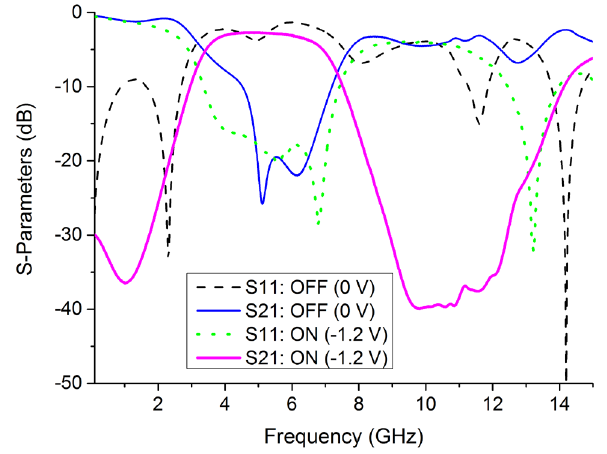
Figure 13. Measured results of the S-parameters in both states.